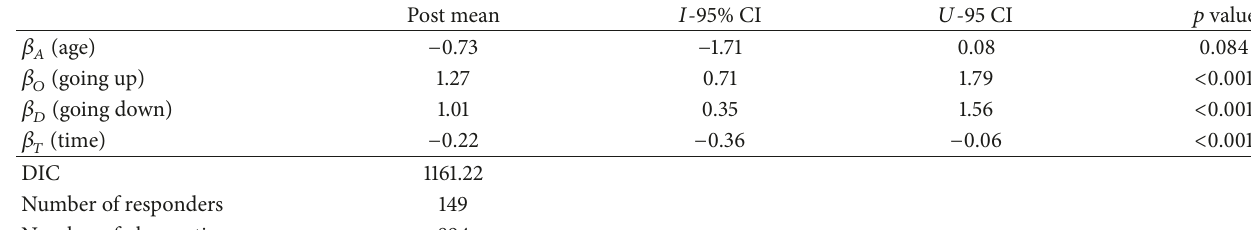
Table 7: Estimated result for the modified